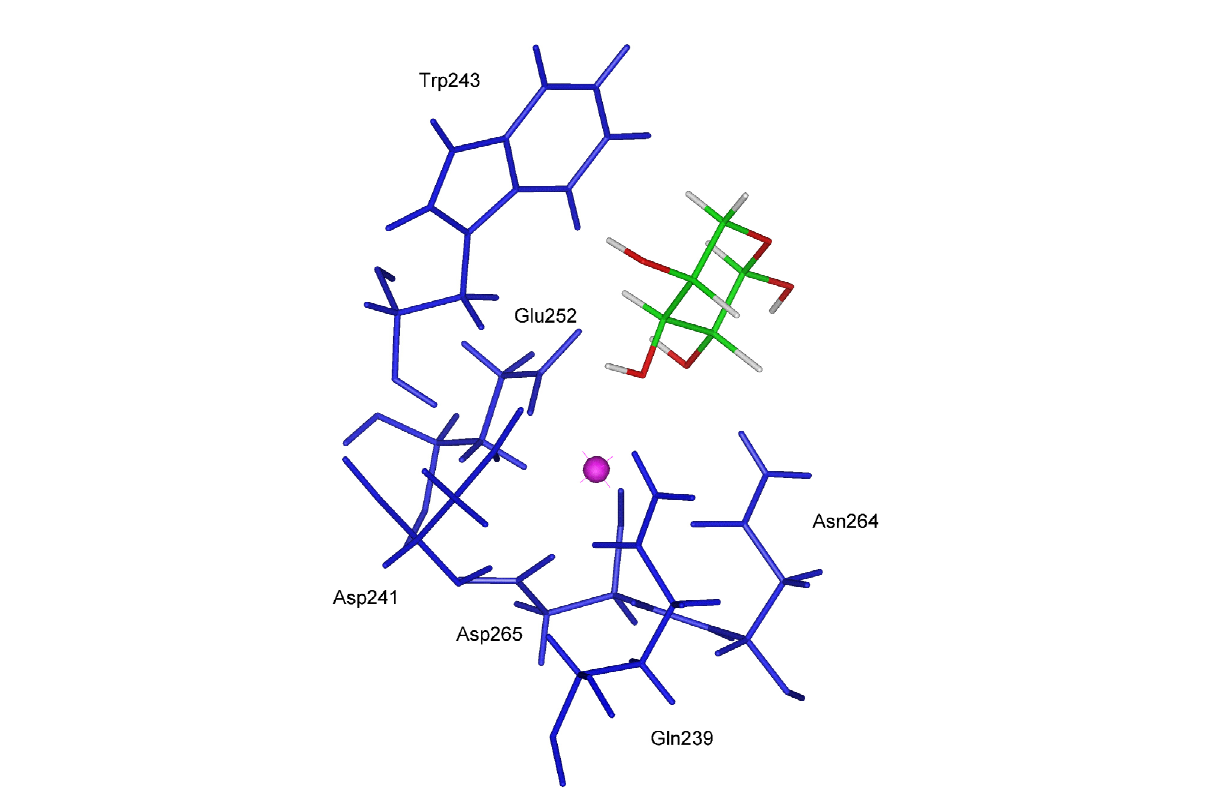
Figure 4. One of the three structure of Xylose optimized in the binding site.